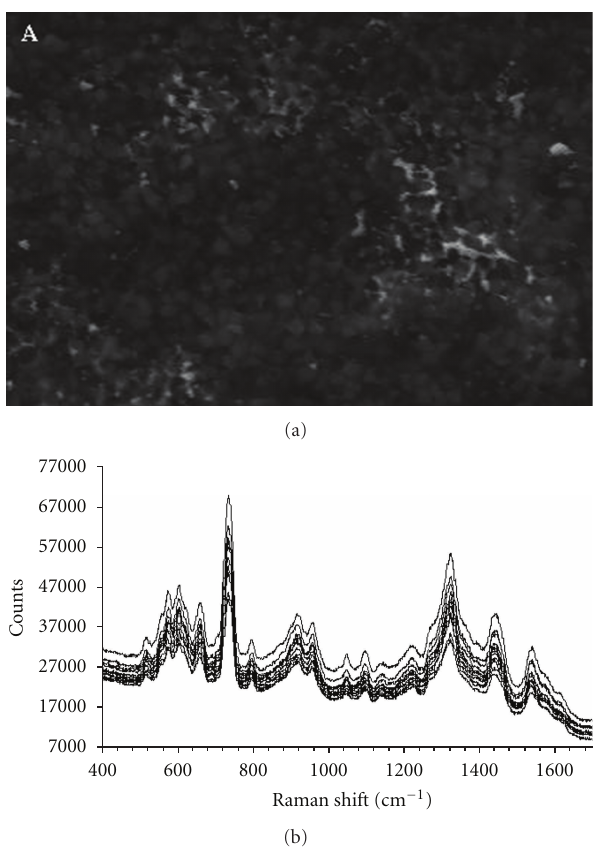
Figure 2: SEM image of an E. coli sample prepared with 4x colloidal suspension (a) and the ten SERS spectra generated from this sample from di ff erent locations